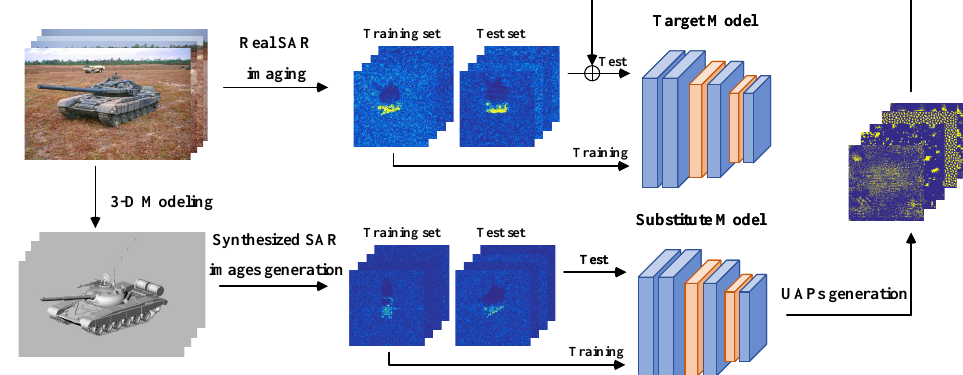
Figure 1. Workflow of the proposed FBUA for the SAR ATR. The simulated SAR images are from the publically accessible SARSIM dataset [38,39], and the real SAR images are from the MSTAR dataset. Please notice that the Parula color map is employed in this article to visualize the gray-scale SAR